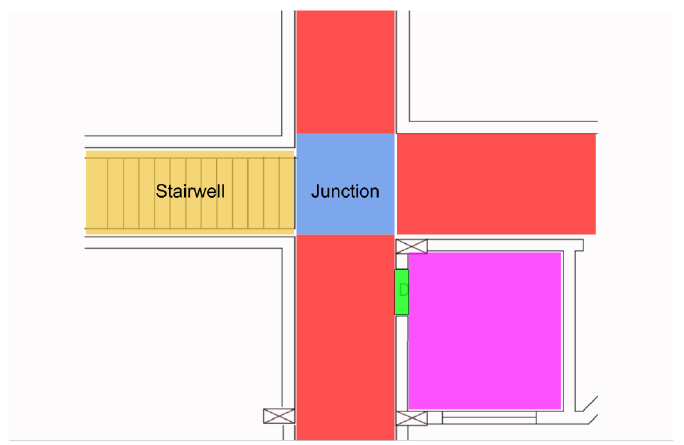
Figure 6. Depiction of junction (blue) and stairwell (yellow)